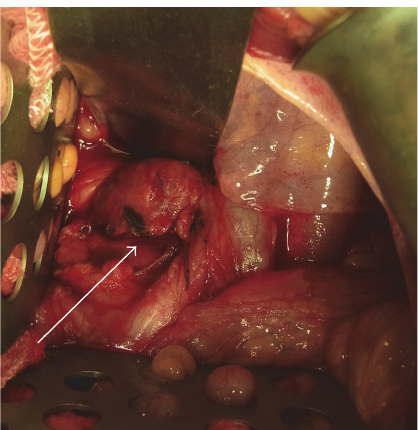
Figure 3: A tumor located in the anterior of the sacrum and consisting of soft, yellowish tissue. The mass was poorly defined and strongly adherent to the sacrum and the common iliac vein.